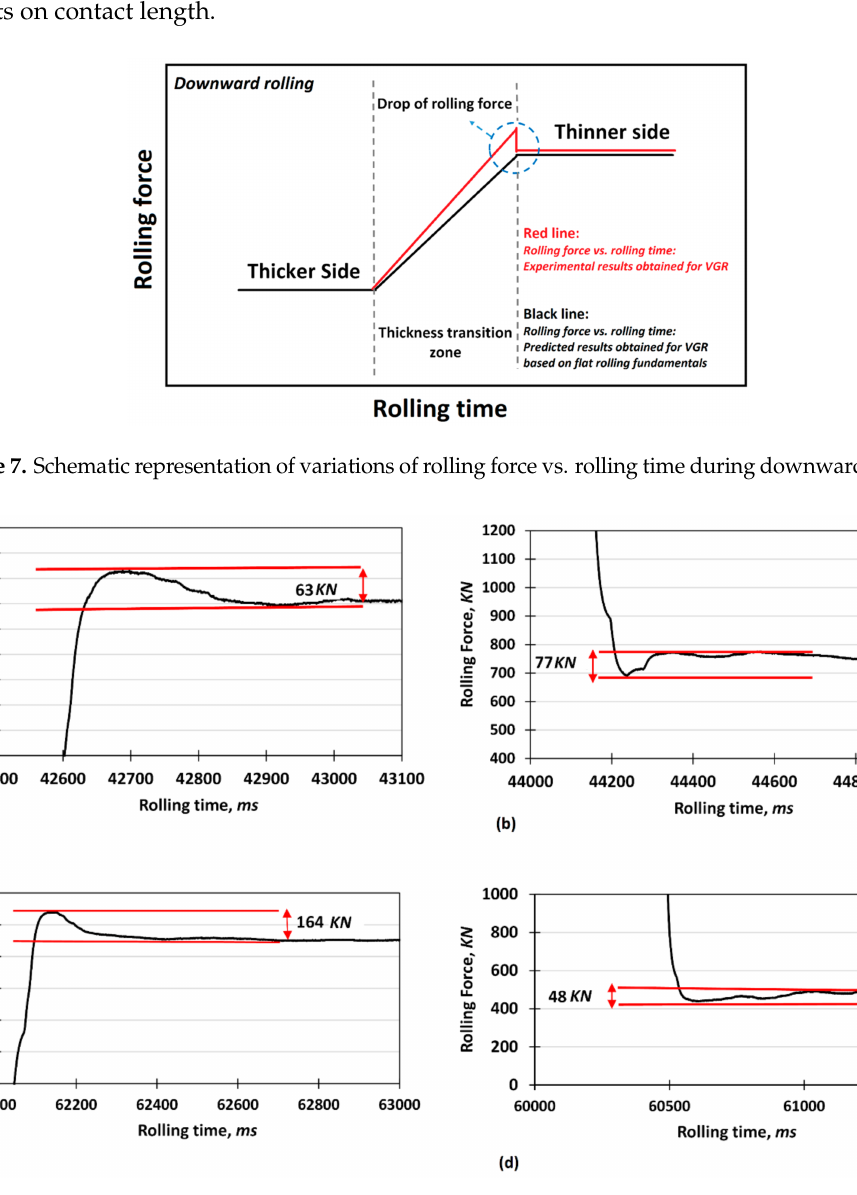
Figure 8. Variations of rolling force with rolling time for ( a ) downward rolling with absolute thickness reduction of 0.2 mm; ( b ) upward rolling with absolute thickness reduction of 0.2 mm; ( c ) downward rolling with absolute thickness reduction of 1 mm; and ( d ) upward rolling with absolute thickness reduction of 1